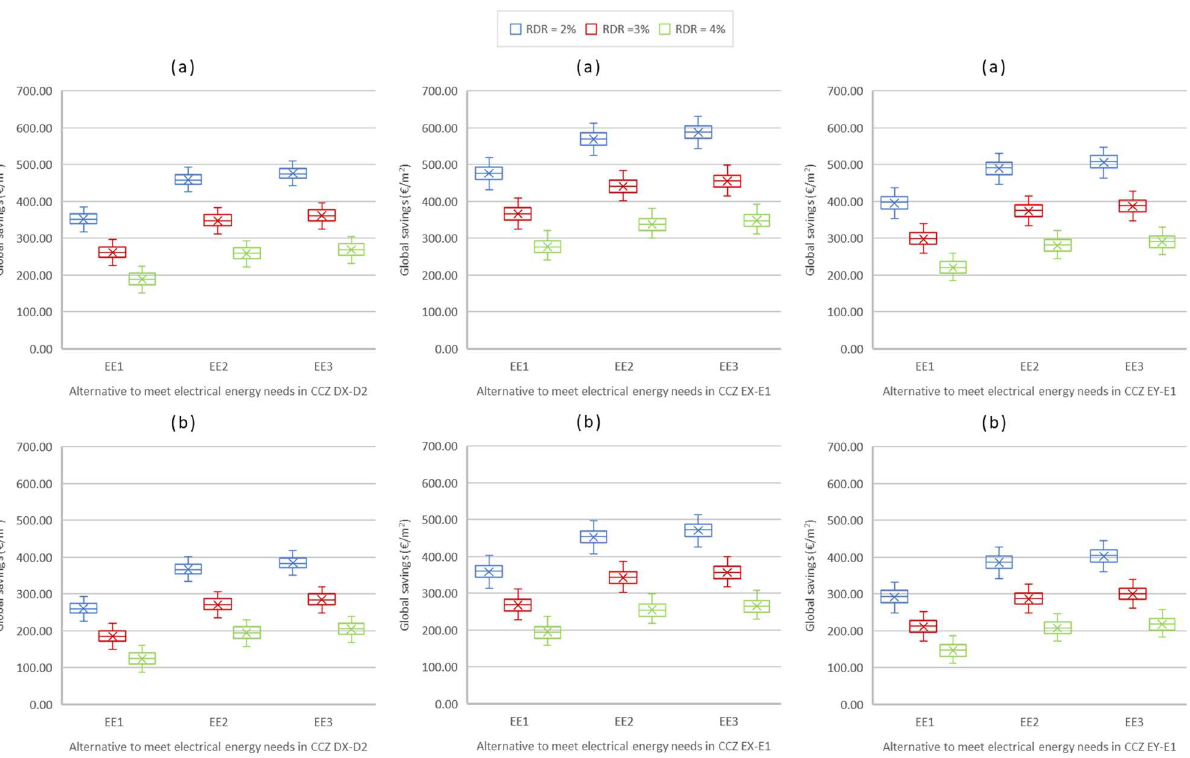
Figure 10. Global savings of all energy renovation solutions, in EUR/m 2 , in each CCZ by real dis- count rate (RDR) and alternative used to meet electrical energy needs, compared to ( a ) the corre- sponding case CCZ-S1-NoInsu-EE1 and ( b ) the corresponding case